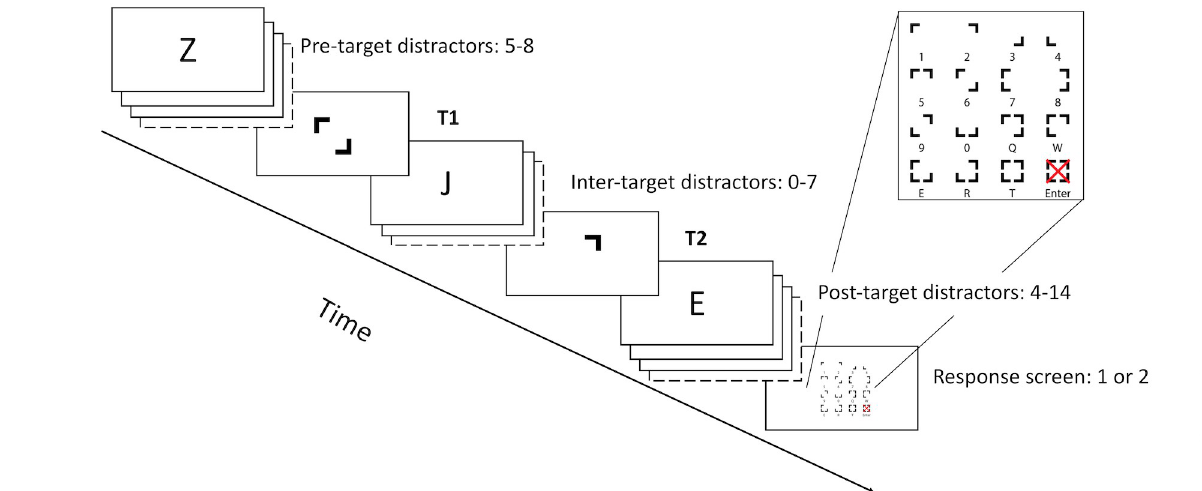
Fig 5. Schematic overview of a single trial with two targets. Every trial started with the presentation of a fixation cross for one second (not shown). The presentation rate of the stimuli was 12 Hz with no inter stimulus interval.